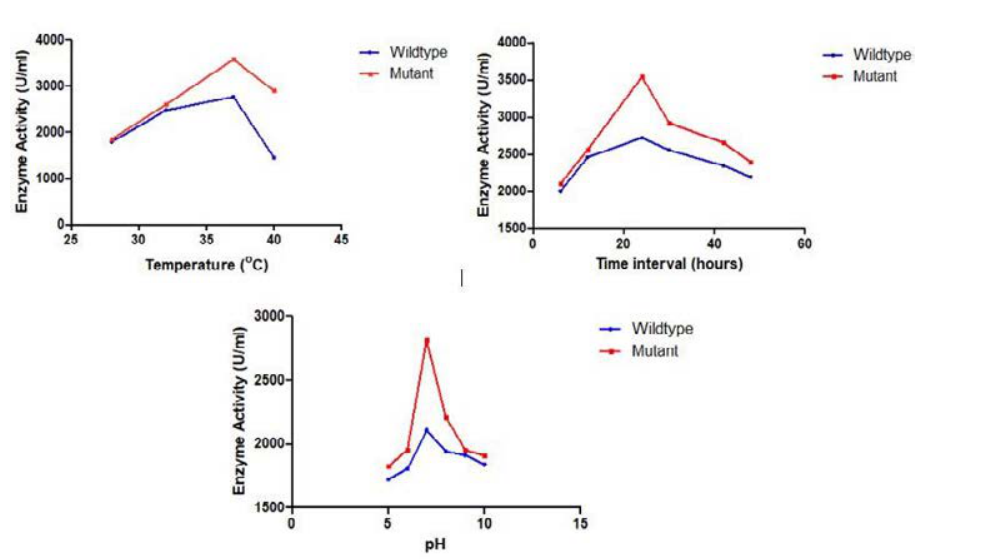
Fig. 4. Optimization of Serrapeptase production for wild and mutant strains on different parameters A) Temperature, B) Incubation period, and C) pH.